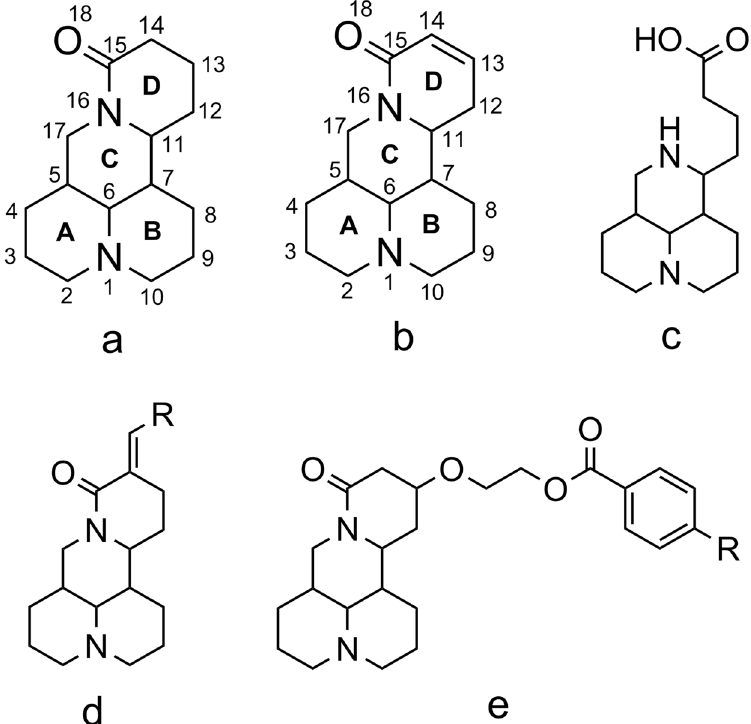
Figure 1. Structures of matrine ( a ), sophocarpine ( b ) and matrine derivatives ( c–e